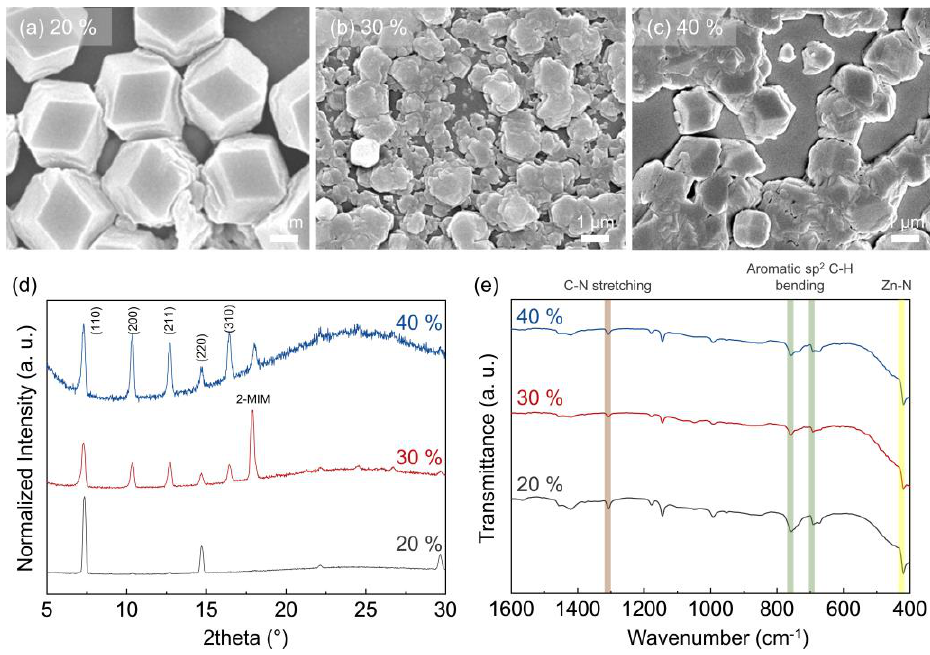
Figure 3. ( a − c ) SEM images (( a ): 20%, ( b ): 30%, and ( c ): 40%), ( d ) XRD patterns, and ( e ) FT-IR spectra for the ZIF-8 grown on the substrates depending on relative humidity (20, 30, and 40%) at chamber temperature of 70 °C.